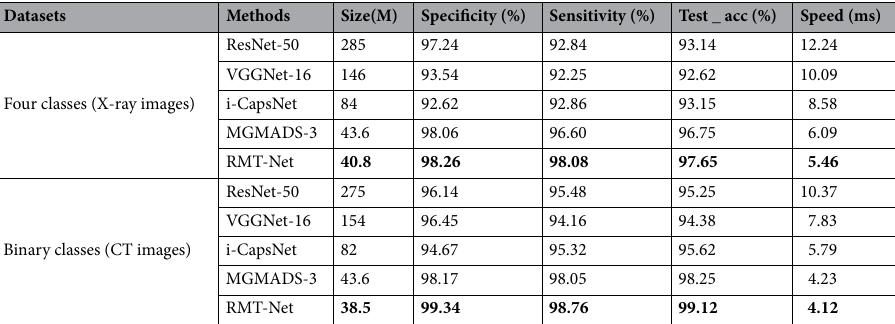
Table 3. The test results of RMT-Net compared to the other four models. Bold value highlights the gain effect of our method in the table.